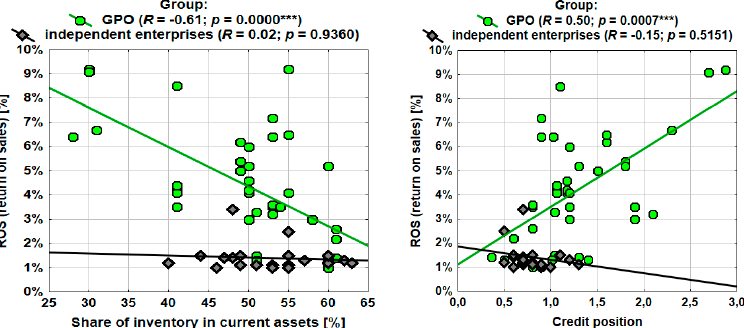
Table 5. Spearman’s rank coefficient of correlation between the profitability level of companies from both groups and the selected indicators—efficiency, share of receivables and inventory and credit position (with result of significance test).